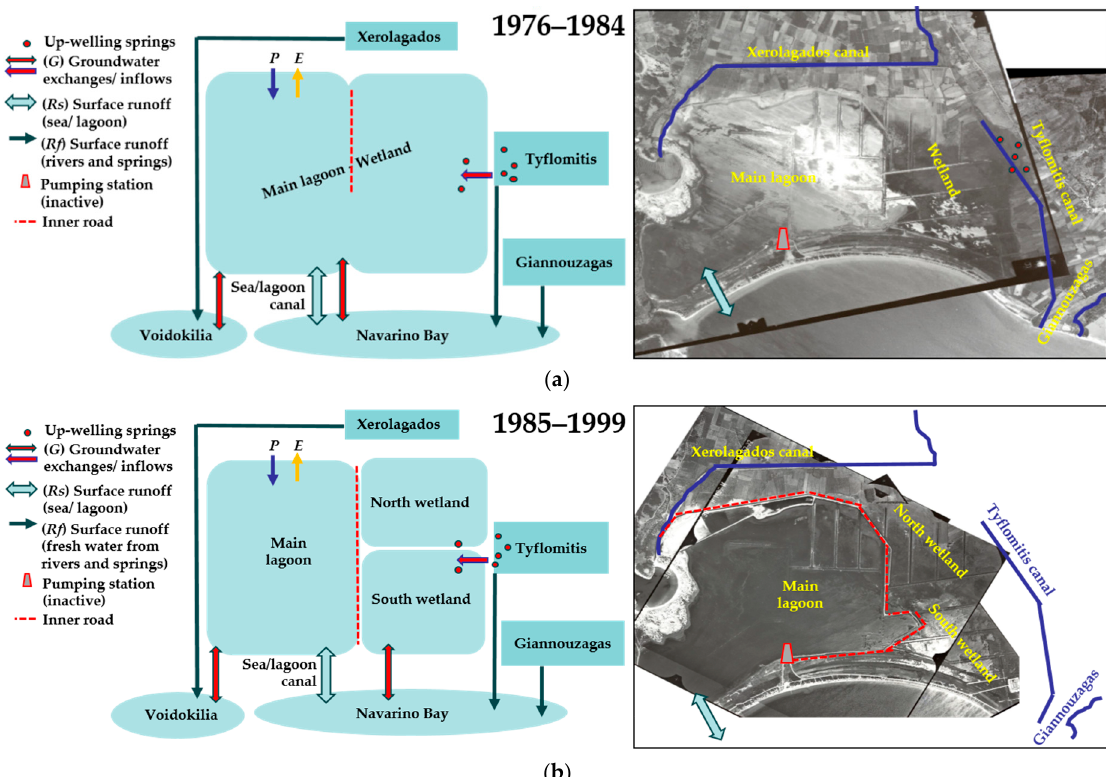
Figure 4. Schematic representation of the hydrologic conditions in the GLw-Natura2000: ( a ) during the 1976–1984 period based on b/w aerial photographs from 1980, and ( b ) during the 1985–1999 period based on b/w aerial photographs from 1992.